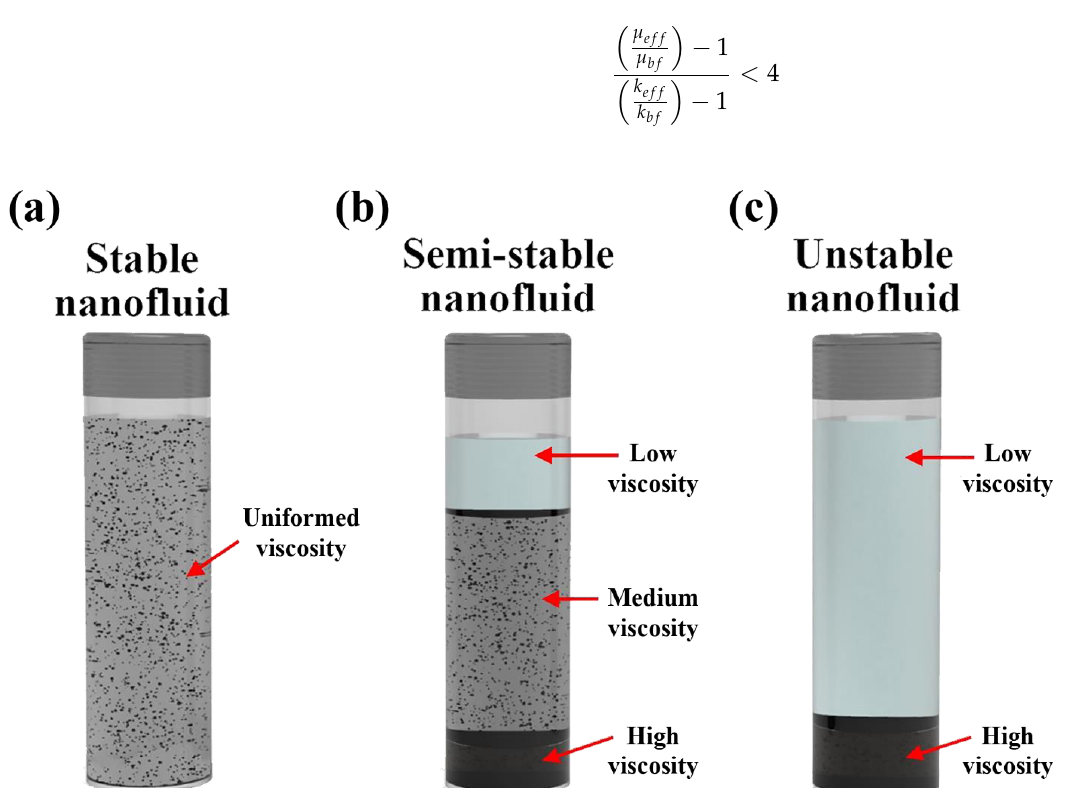
Figure 17. Nanofluids viscosity classification, where ( a ) shows the stable, ( b ) illustrates semistable, and ( c ) demonstrates the unstable cases of the suspension.